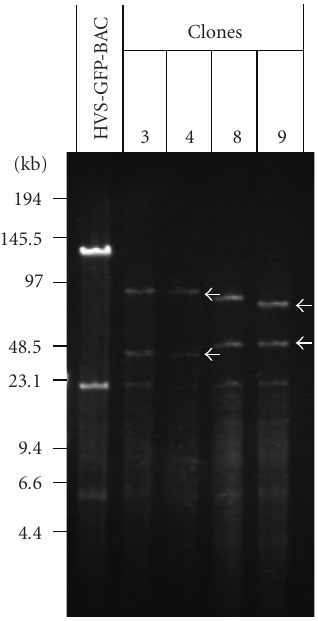
Figure 4: AgeI restriction analysis of cointegrants formed by homologous recombination. The mutated version of the ORF51 gene contains an AgeI restriction site. This extra restriction site can be used as a marker for the integration of the pKOV Kan mORF51 vector into the HVS genome. Pulse field gel electrophoresis of possible cointegrant clones 3, 4, 8, and 9 reveals successful integration, as the ∼ 130 kb band seen in HVS-GFP-BAC is cleaved into 2 smaller bands (indicated by arrows) due to the introduced restriction site. The 2 di ff erent orientations of pKOV Kan mORF51 can be visualised as clones 3 and 4 show a restriction pattern with bands at 45 kb and ∼ 90 kb, whereas clones 8 and 9 have bands at 52kb and ∼ 85 kb. This 7kb di ff erence in the restriction site corresponds to the length of pKOV Kan